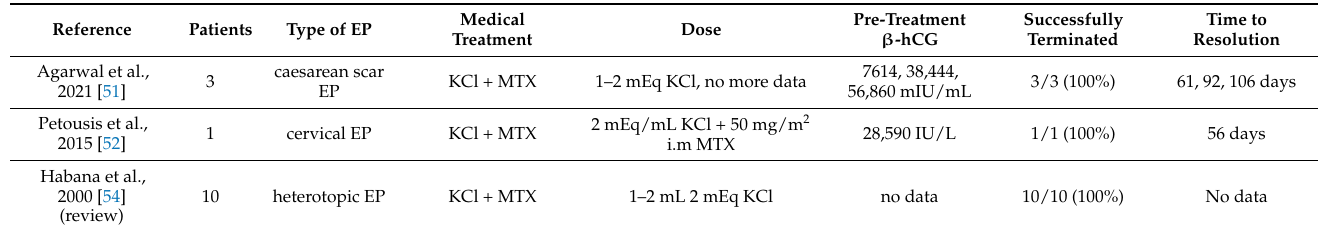
Table 3. Review of the literature describing KCl treatment in